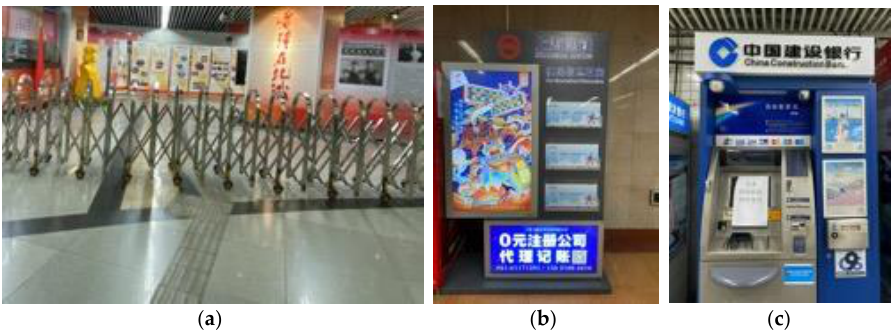
Figure 13. The practical situation of transfer space environments at sample stations: ( a ) Blind lane occupation; ( b ) map information without supplemental delivery; ( c ) faulty equipment. Images cour-